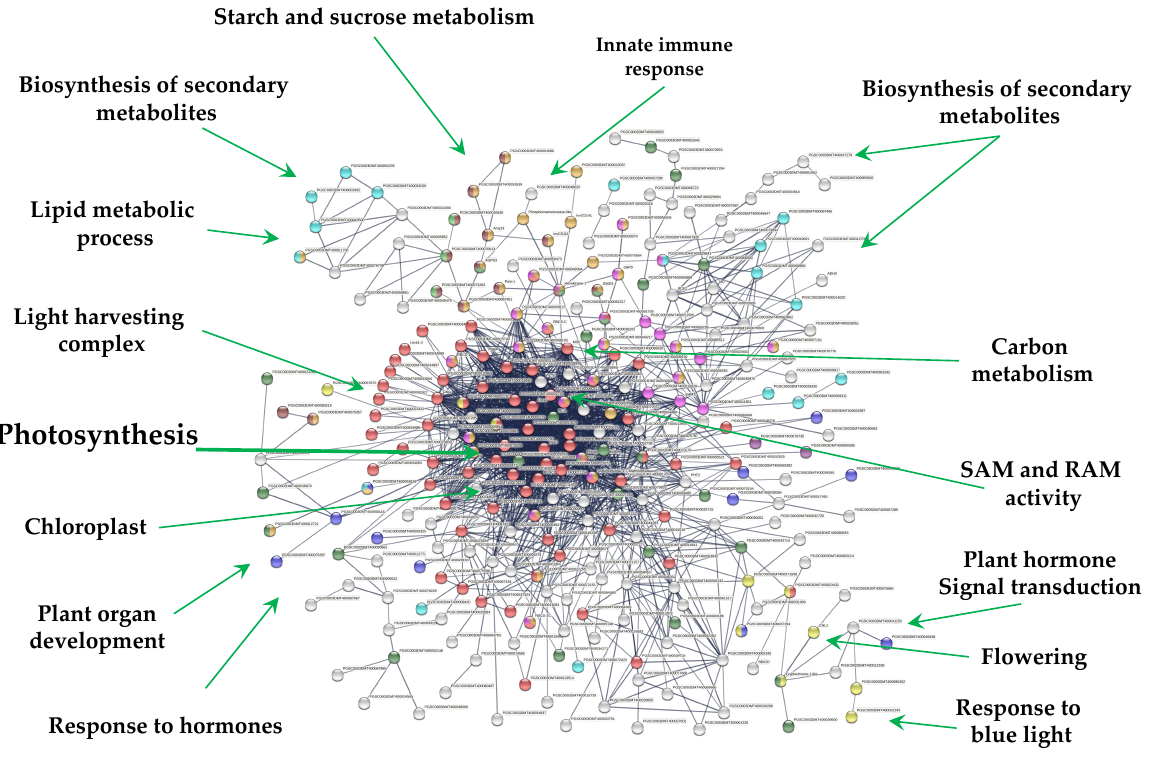
Figure 7. PPI network of down-regulated genes derived from the STRING database of potato S. tuberosum from the transcriptomic-wide analysis with high confidence (0.700). Cluster is highlighted with the name of the function. The figure represents a full network, the edges indicate both functional and physical protein